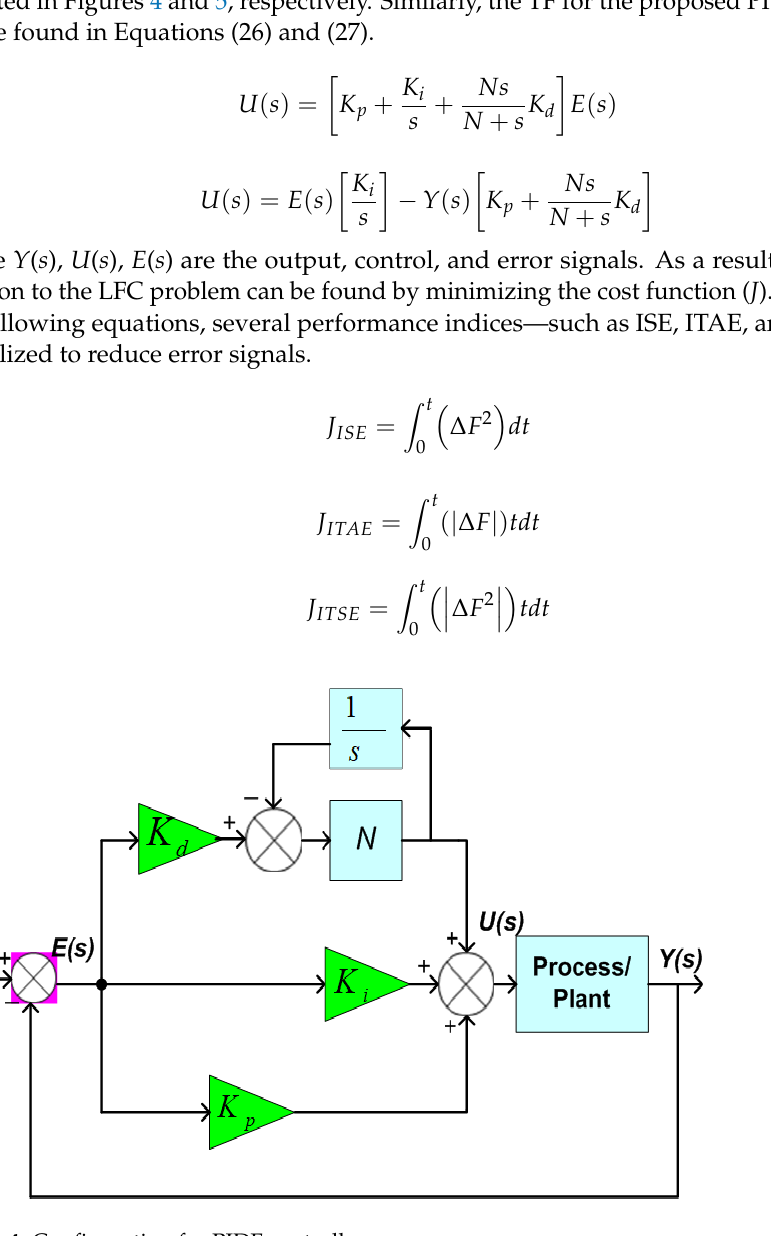
Figure 4. Configuration for PIDF controller.